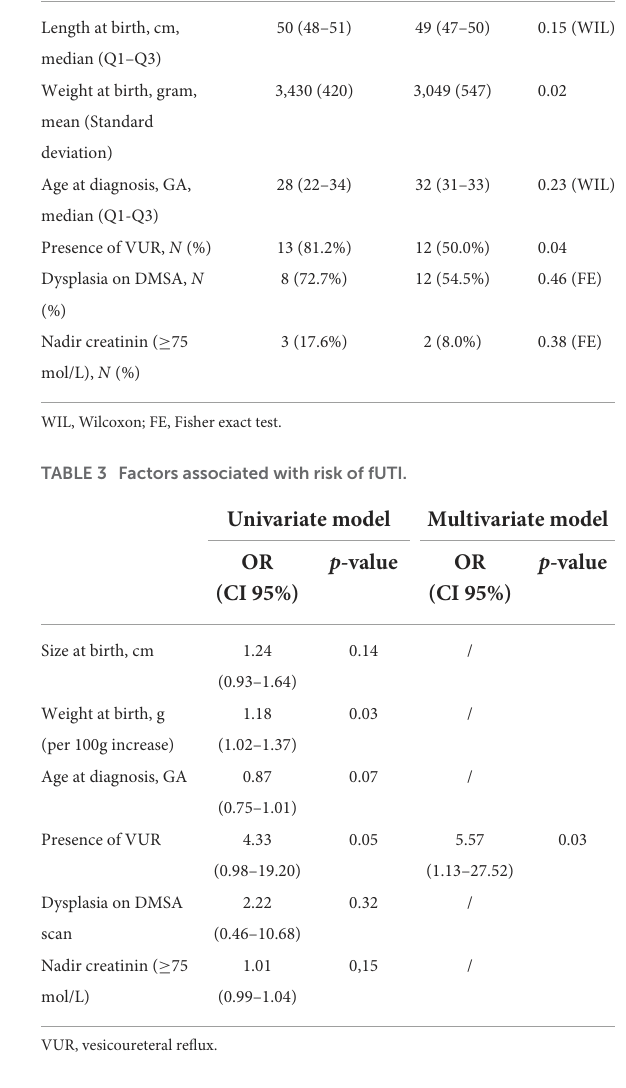
(Table 3): birth weight, age at diagnosis, and presence of VUR. There was a statistically significant effect of the presence of VUR on the presence of febrile urinary tract infections ( p = 0.03) with an odds ratio of 6 [CI 95% = (1.13–27.52)].